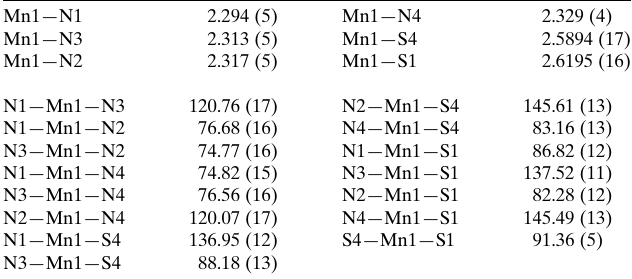
Table 1 Selected geometric parameters (A˚ , (cid:5)